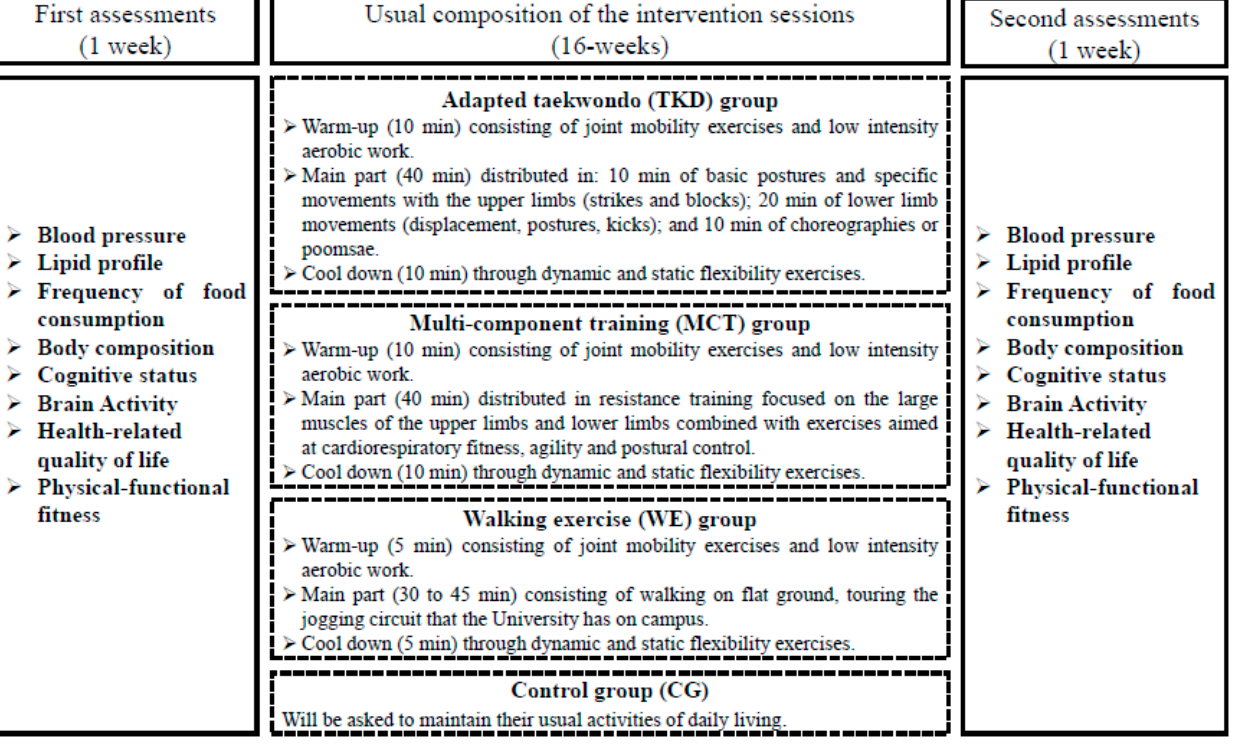
Figure 2. Assessments and usual sessions of the intervention. Legends: CG: Control group. MCT: Multi-component training. TKD: Adapted taekwondo. WE: Walking exercise.